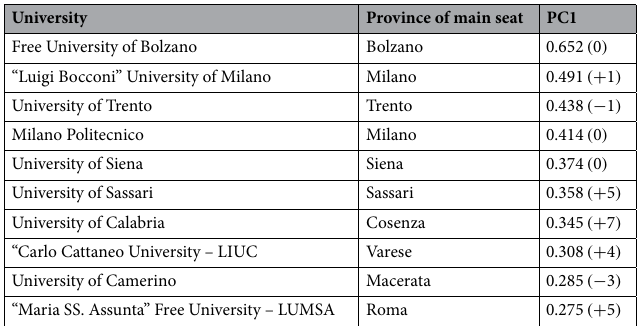
Table 5. Top ten universities in the ranking of the principal component PC1 associated to the CENSIS overall score. In the last column, the number in round brackets indicates the position variation in the PC1 ranking with respect to the original one.